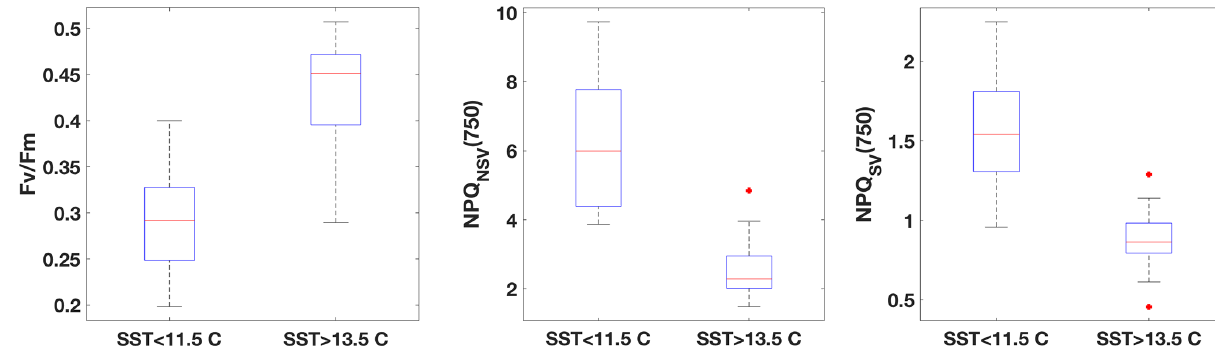
Figure 4. Comparison of FRRf data from underway samples, grouped based on SST. All parameters are significantly different between the two respective water masses (Wilcoxon rank-sum test, p (cid:28) 0 . 01).